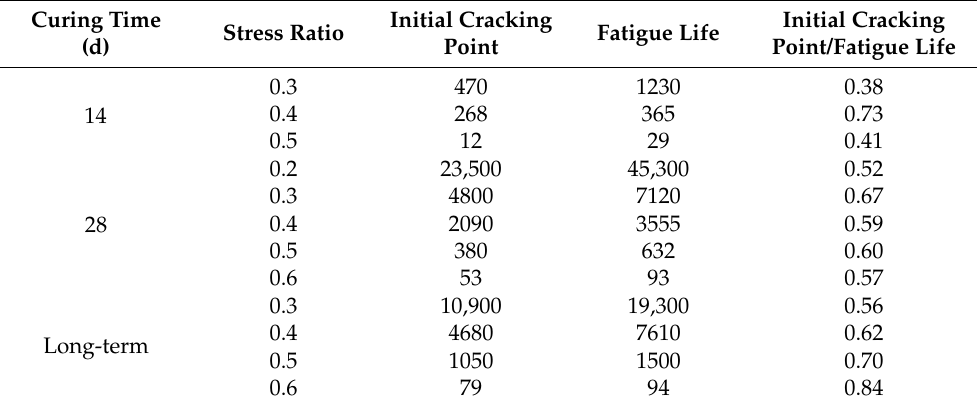
Table 7. The characteristic of the initial cracking point and failure point of